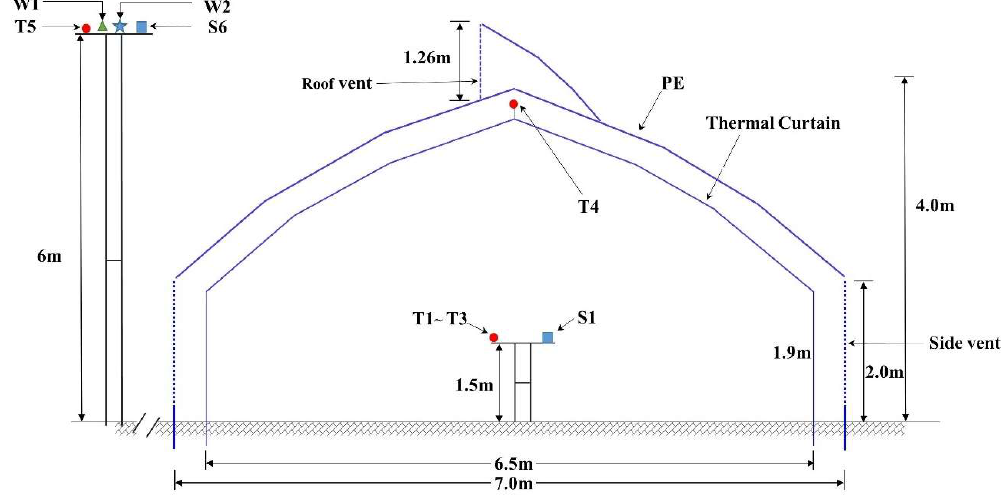
Figure 2. Experimental greenhouse at Daegu (latitude 35.53 ◦ N, longitude 128.36 ◦ E).